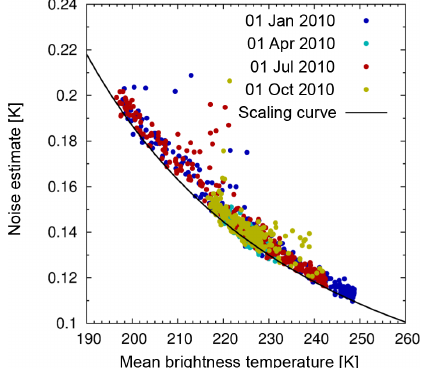
Figure 3. Noise estimates for the AIRS 15µm brightness tempera- ture data set versus mean background temperature. Individual noise estimates (colored dots) were obtained from radiance measurements within globally distributed boxes of 90 × 90 satellite footprints on different days. The few outliers with high noise are due to cases of small-scale waves being misinterpreted as noise. The Planck scal- ing curve (black curve) is defined by a NEdT of 0.109K at a 250K scene